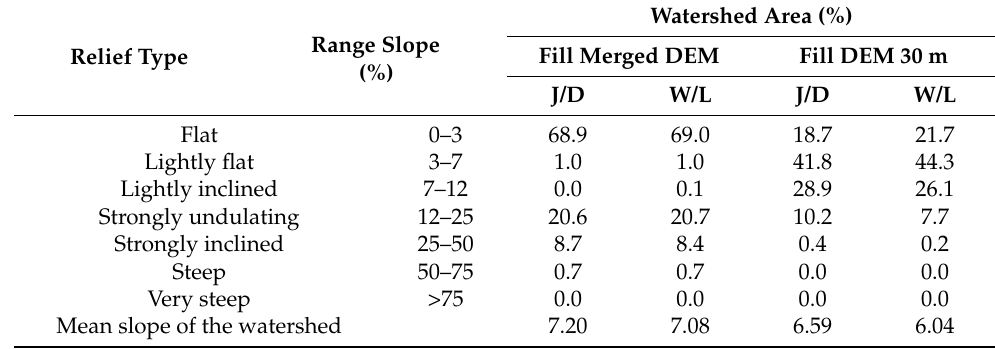
Table 4. Area percentage regarding the relief type and mean slope of the